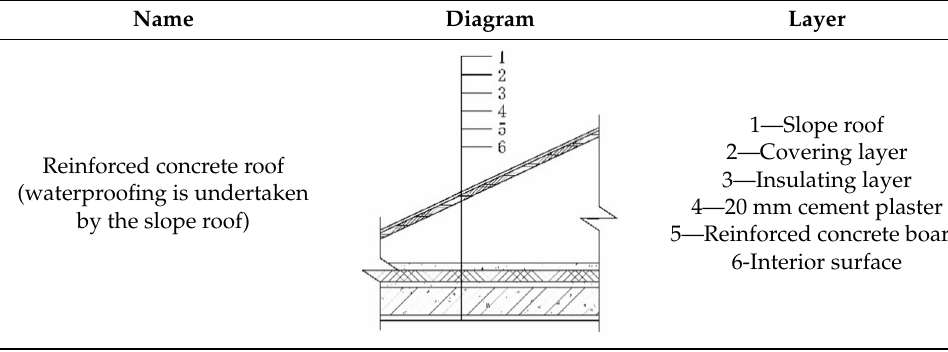
Table 5. Typical thermal insulation structure of roof for rural